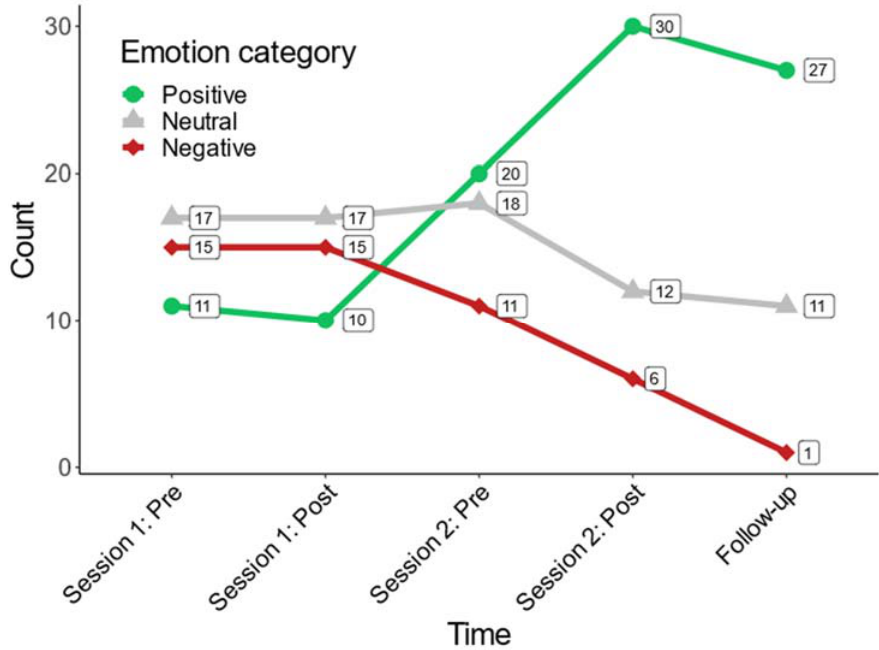
Figure 4. Line plot of frequencies of selected emotions over time. Note, Labels correspond to fre ‐ quencies for the respective emotions at each time of measurement.